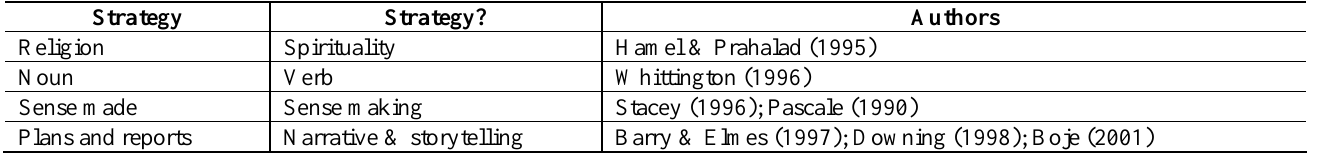
Table 2: Strategic